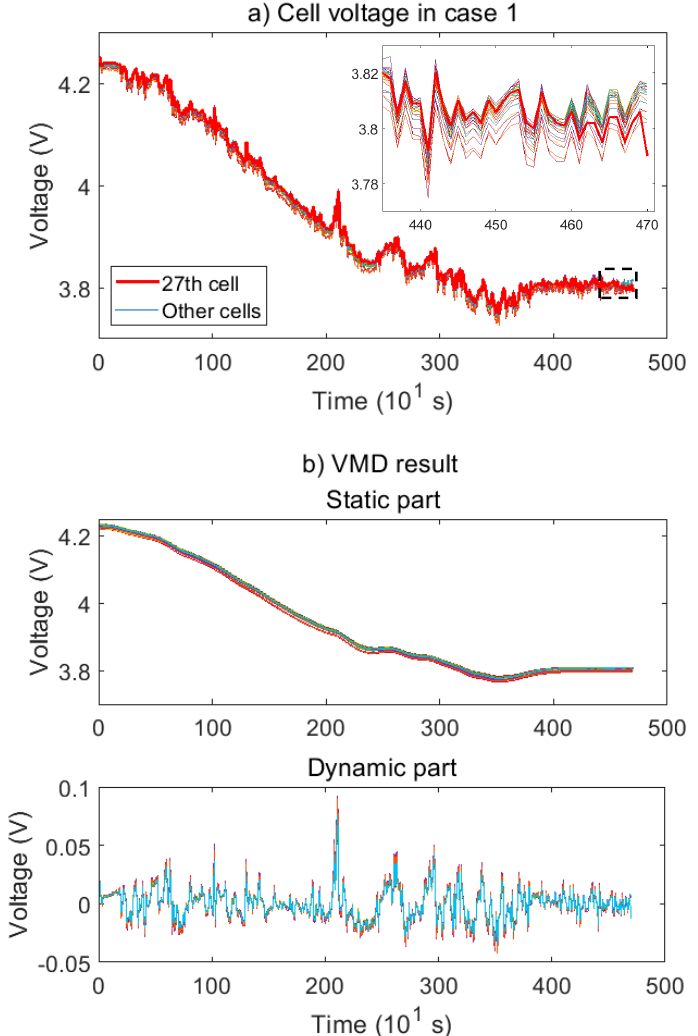
Figure 2. Voltage signal records in the first case, ( a ) Voltage signal records of 97 cells until the alarm of BMS ( b ) Decomposed voltage signal parts.